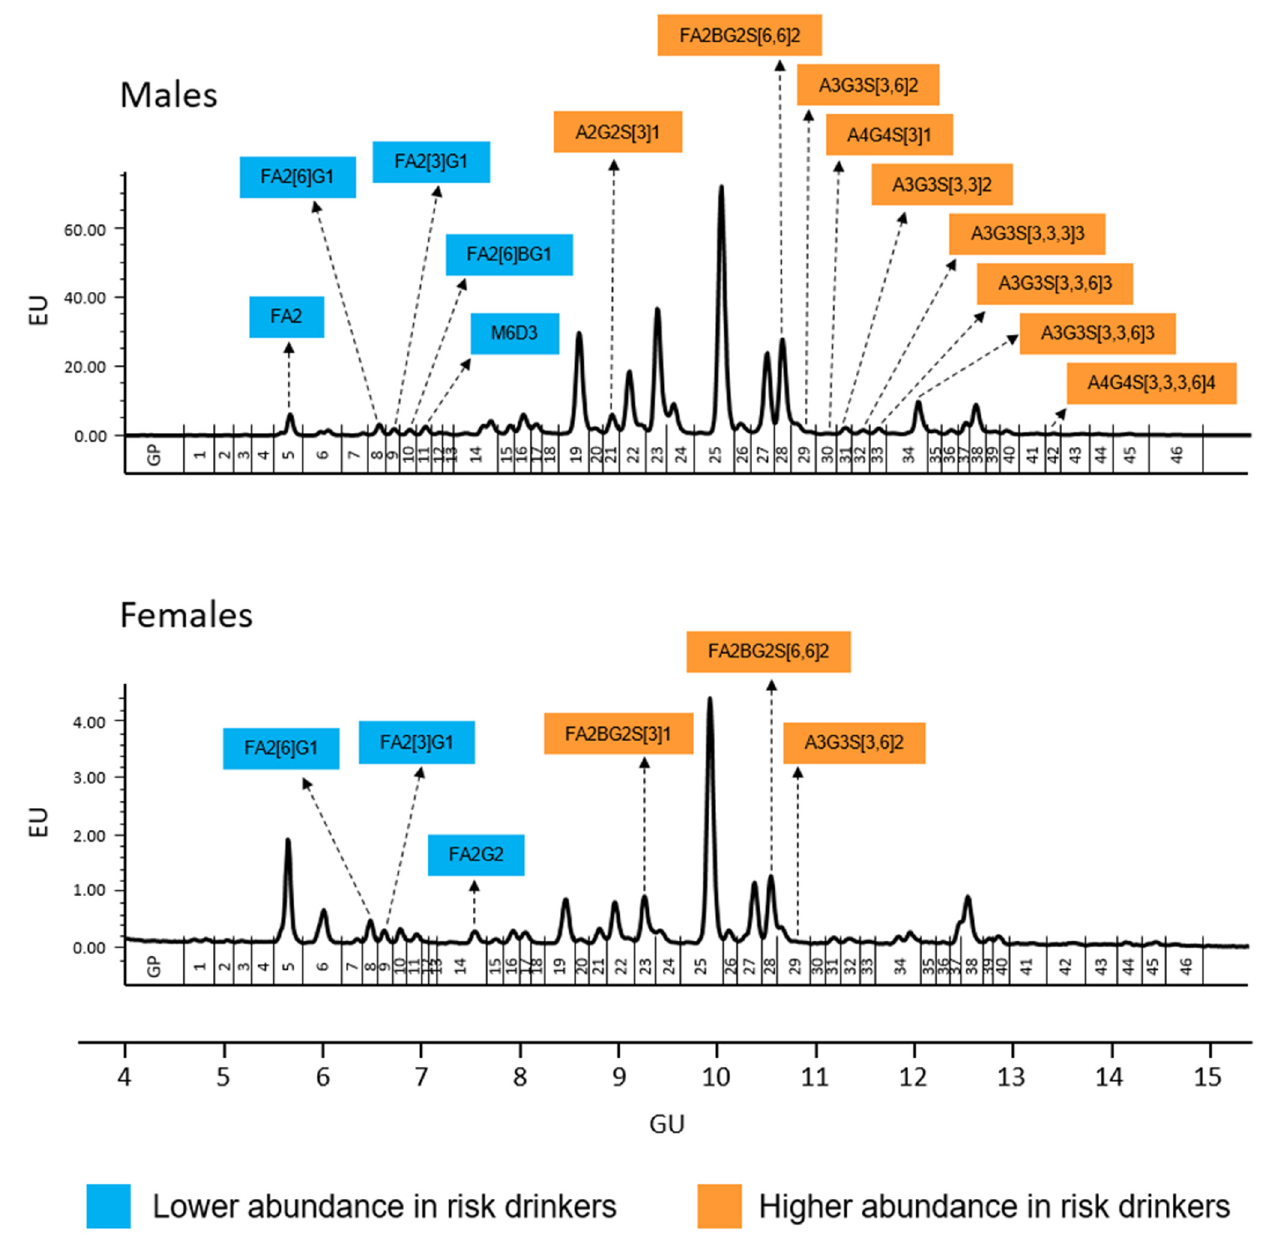
Figure 1. Serum N -glycome representative chromatograms in men (upper panel) and women (lower panel). Glycan peaks (GPs) are numbered from GP1–GP46 and assigned as in Saldova et al. [12]. The integration areas, together with a major structure presented in each glycan group are given. Significant (uncorrected p -values <0.05) increases in relative peak area (in %) between risk drinkers and non-risk drinkers are marked with orange and in case of significant decrease are marked with blue. After sequential Bonferroni correction, only changes in GP9, GP31, GP33, and GP34 in men would be significant at an alpha level of 0.05. Structure abbreviations: all N -glycans have two core GlcNAcs; F at the start of the abbreviation indicates a core-fucose α 1,6-linked to the inner GlcNAc; Mx, number (x) of mannose on core GlcNAcs; Ax, number of antenna (GlcNAc) on trimannosyl core; B, bisecting GlcNAc linked β 1,4 to β 1,3 mannose; Gx, number (x) of β 1,4 linked galactose on antenna; Sx, number (x) of sialic acids linked to galactose.